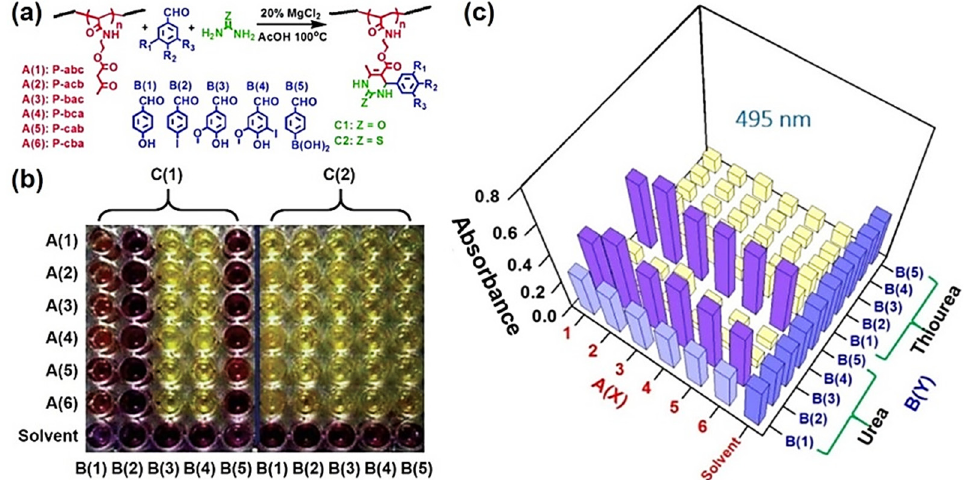
Figure 2. The high-throughput synthesis and screening of Biginelli-type polymers. ( a ) High-throughput synthesis of 60 polymers; ( b ) high-throughput screening of the radical-scavenging ability of the polymers. Polymer solution samples in a 96-well plate (100 µL, 5 mg/mL in CH 3 CN/H 2 O (1/1)) with CH 3 CN/H 2 O (1/1) solvent as the control, with the subsequent addition of the DPPH radical (10 µL, 20 mg/mL in CH 3 CN/H 2 O (1/1)); ( c ) UV absorbance of polymer solutions (100 µL, 5 mg/mL in CH 3 CN/H 2 O (1/1)) at 495 nm after adding DPPH radical. Reprinted with permission from ref. [25] . Copyright © 2017 Royal Society of Chemistry. All rights reserved.